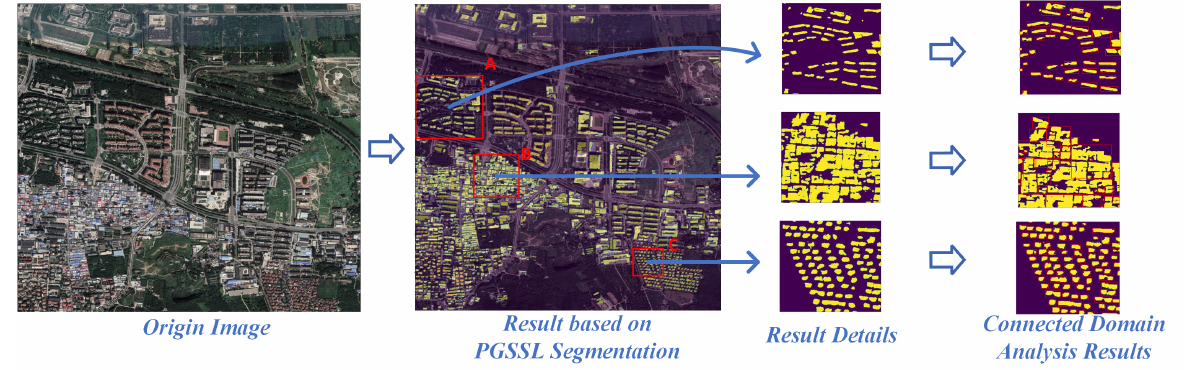
Figure 2. Overview of Regional PV Potential